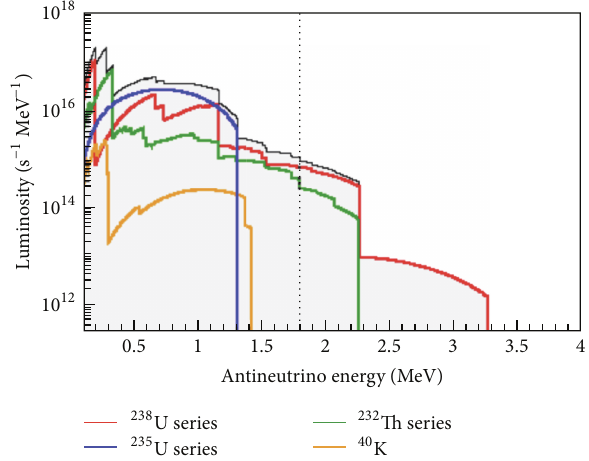
Figure 1: The geoneutrino luminosity as a function of energy is shownforthemostimportantreactionchainsandnuclides[4].Only geoneutrinos of energies above the 1.8MeV energy (vertical dashed line) can be detected by means of the inverse beta decay on target protons shown in